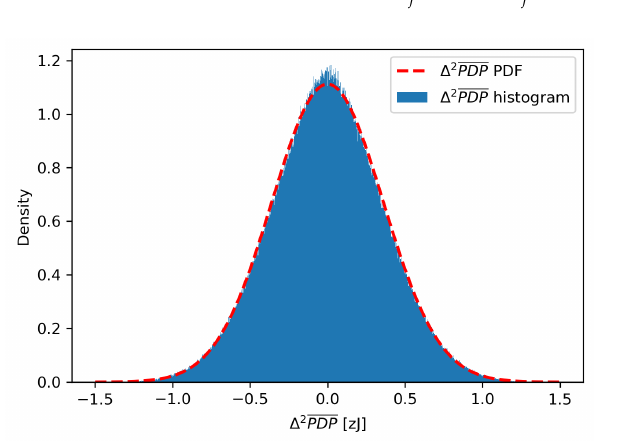
Figure 8. ∆ 2 PDP histogram and probability